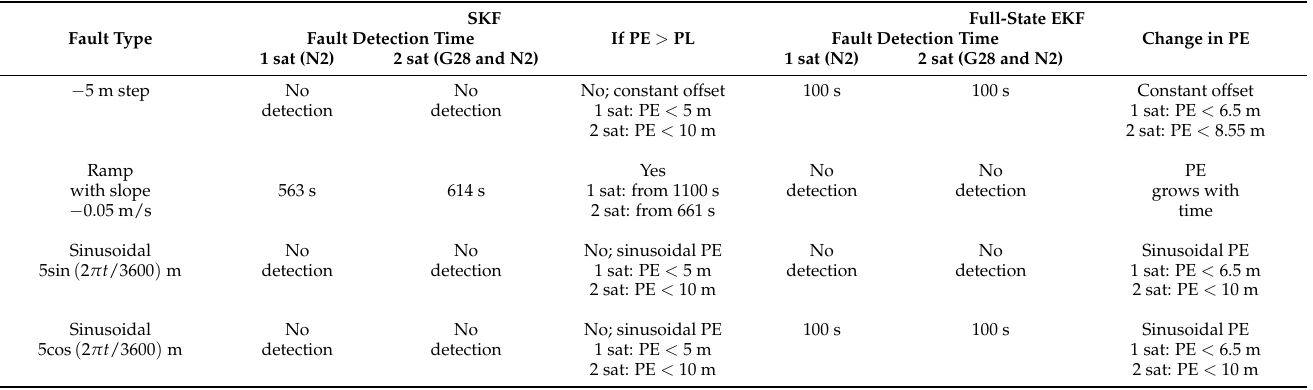
Table 1. Fault detection performance of SKF and full-state EKF. Fault detection time is calculated from the beginning of simulation. PE stands for position error. It can be horizontal or vertical PE. The corresponding PL is HPL or VPL. Maximum of horizontal PE and VPE is noted under PE. “sat” stands for